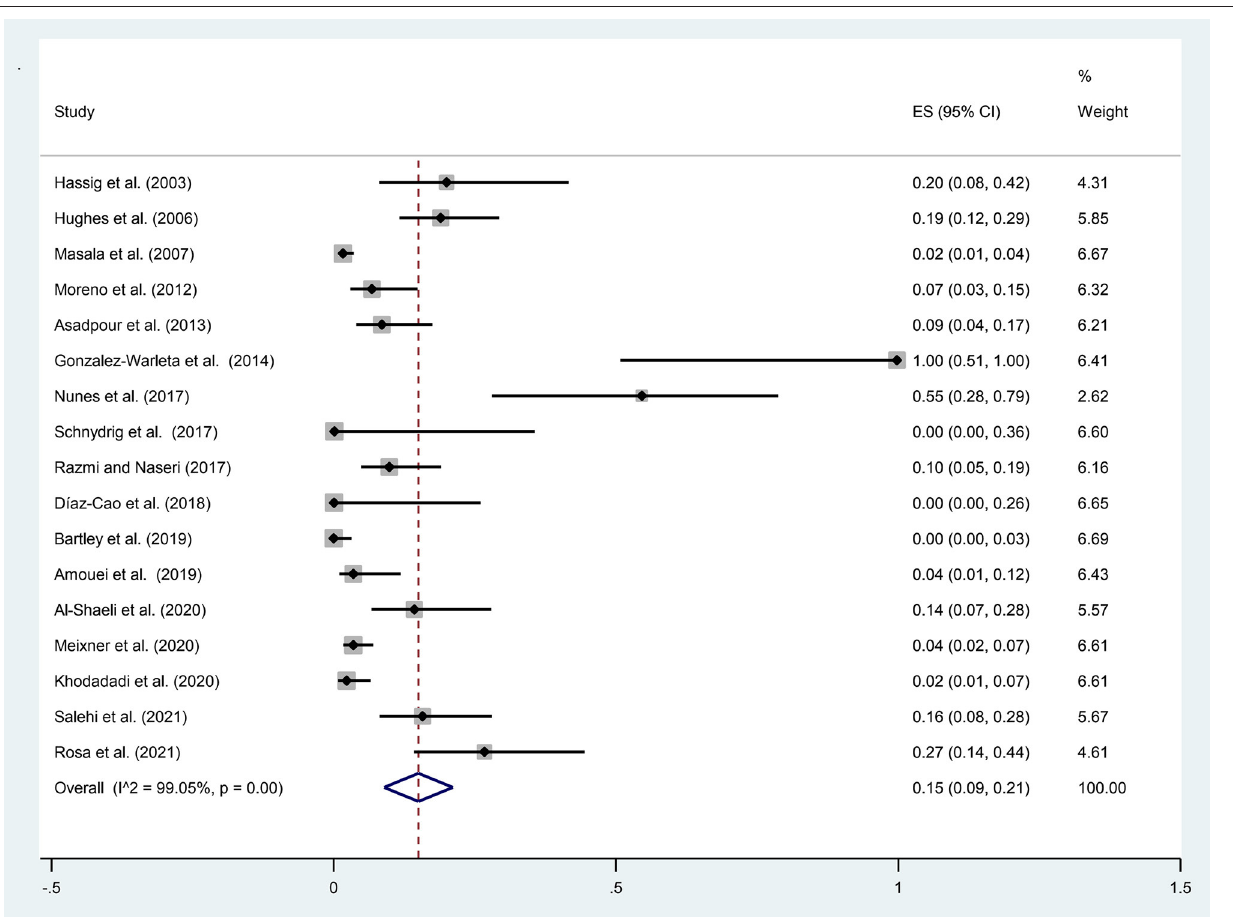
FIGURE 2 | The prevalence of N. caninum infection in the aborted fetuses of sheep using molecular